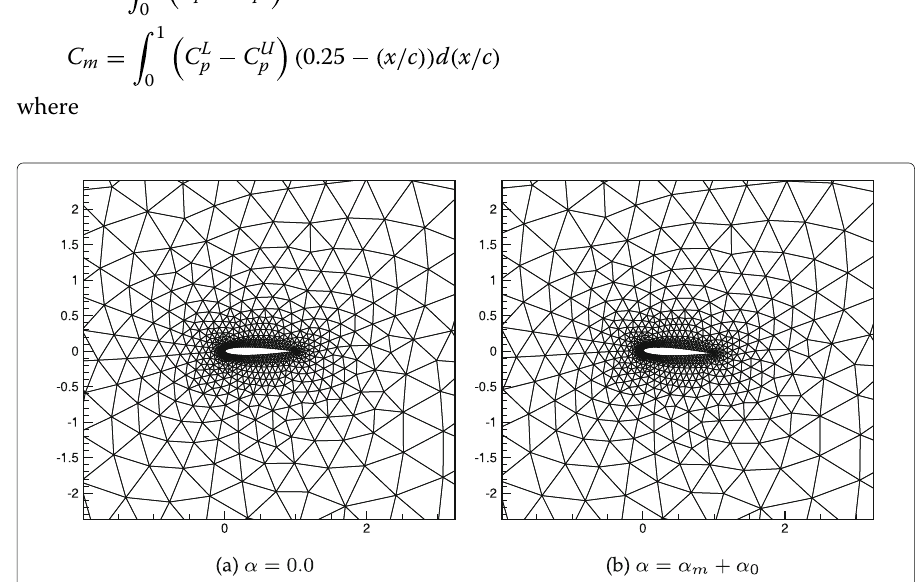
Fig. 9 Zoomed-in mesh near the airfoil. left: initial mesh; right: mesh at maximum angle of